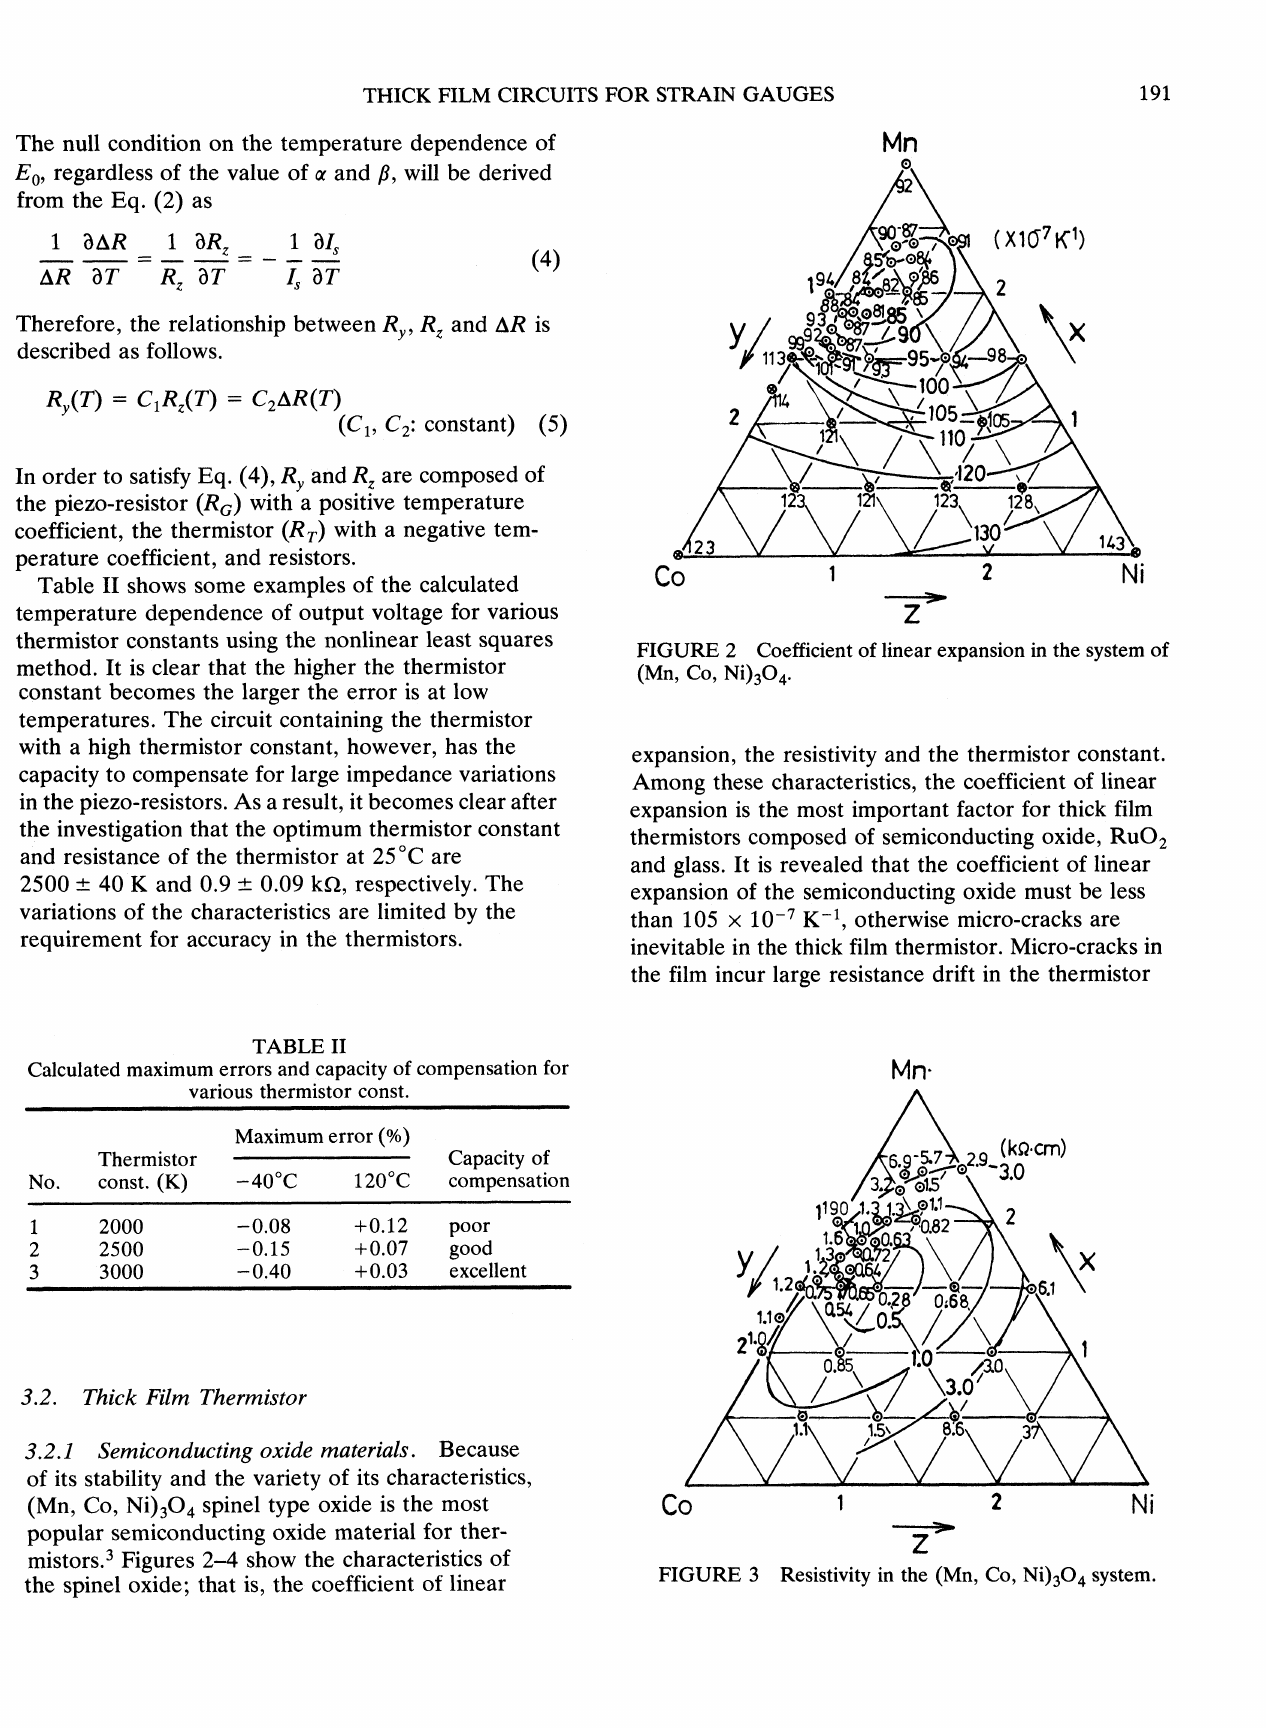
FIGURE 3 Resistivity in the (Mn, Co, Ni)30